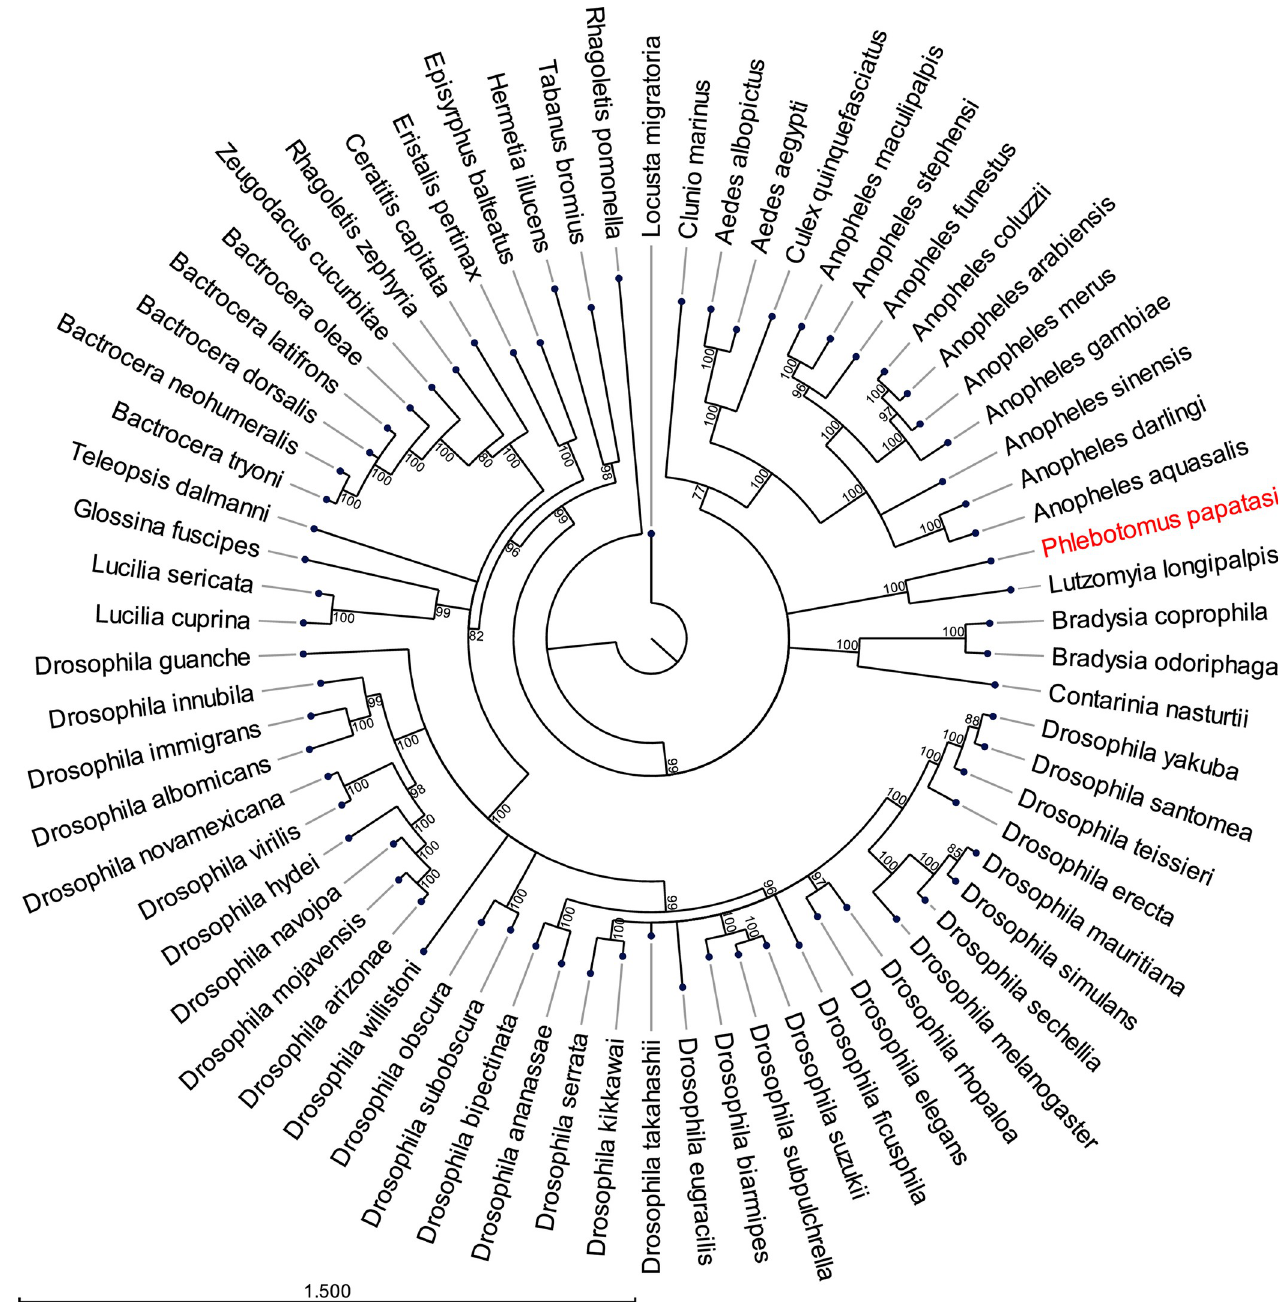
Fig 4. Neighbour-joining tree of dipteran Ago2 protein sequences. Full length Ago2 sequences were obtained for the Order Diptera from NCBI (see S2 Table for accession numbers) and aligned with the PP9ad-derived Ago2 consensus sequence. The phylogeny was reconstructed using the neighbour-joining method and Jukes-Cantor substitution model and rooted on Locusta migratoria . The phylogram is the result of 500 bootstrap replications. The branch lengths are drawn to scale and the scale bar in the bottom left represents 1.5 substitutions per site.